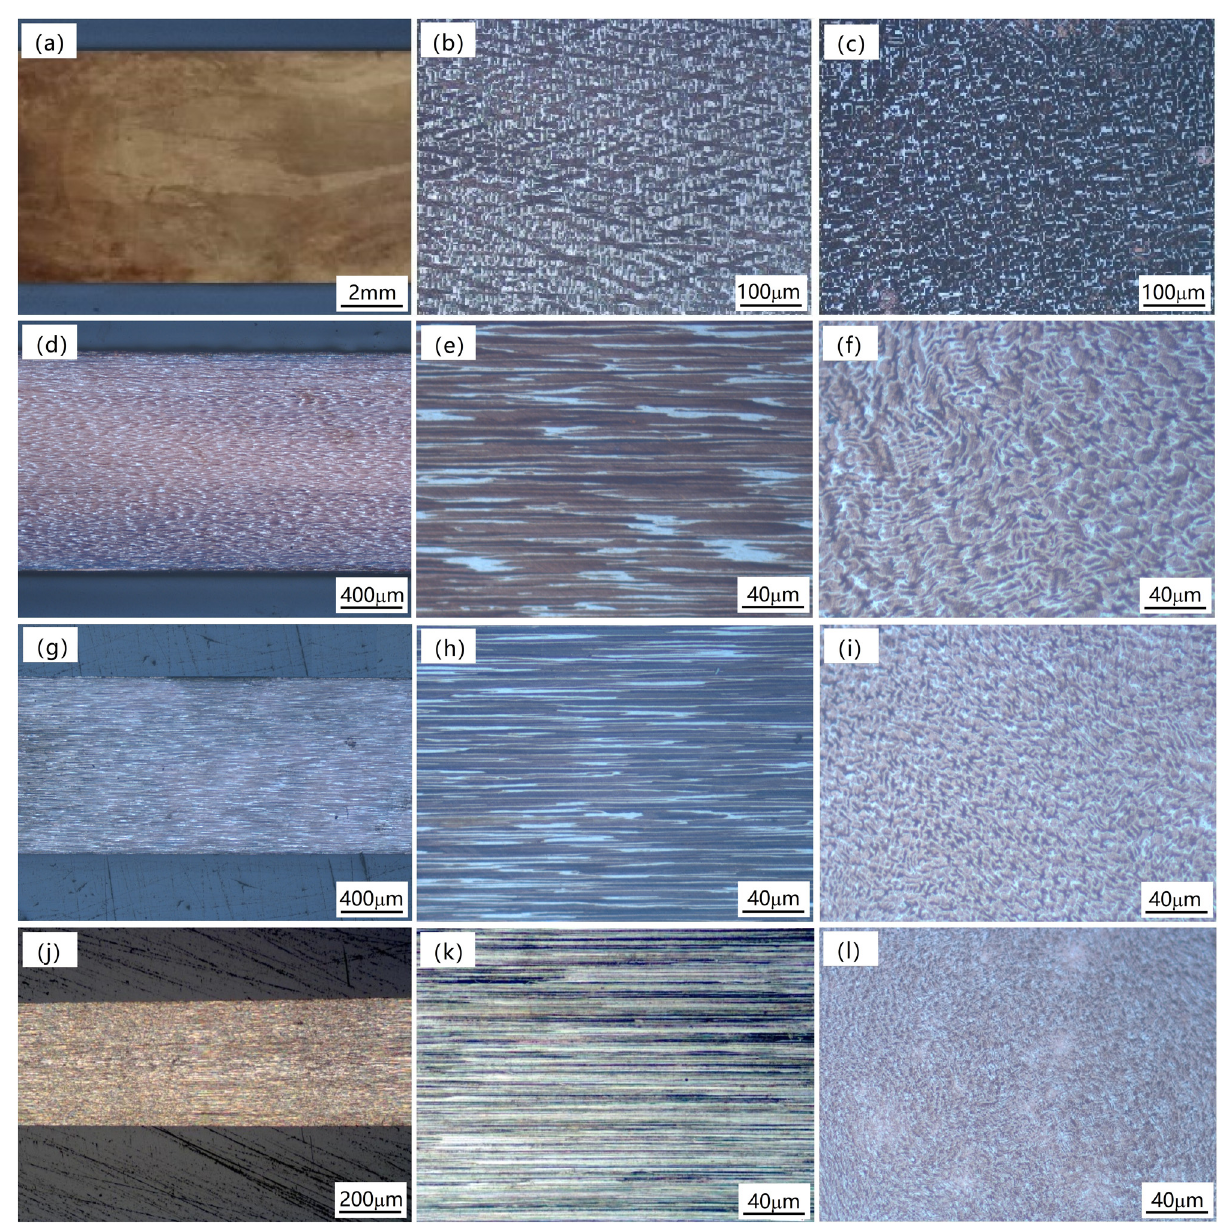
Figure 2: The longitudinal macrophotograph, longitudinal, and transverse microstructure of as - cast rod and as - drawn wire with di ff erent diameters ( a – c – 7.83 mm, η = 0; d – f – 2.13 mm, η = 2.6; g – i – 1.00 mm, η = 4.1; j – l – 0.45 mm, η = 5.7 )